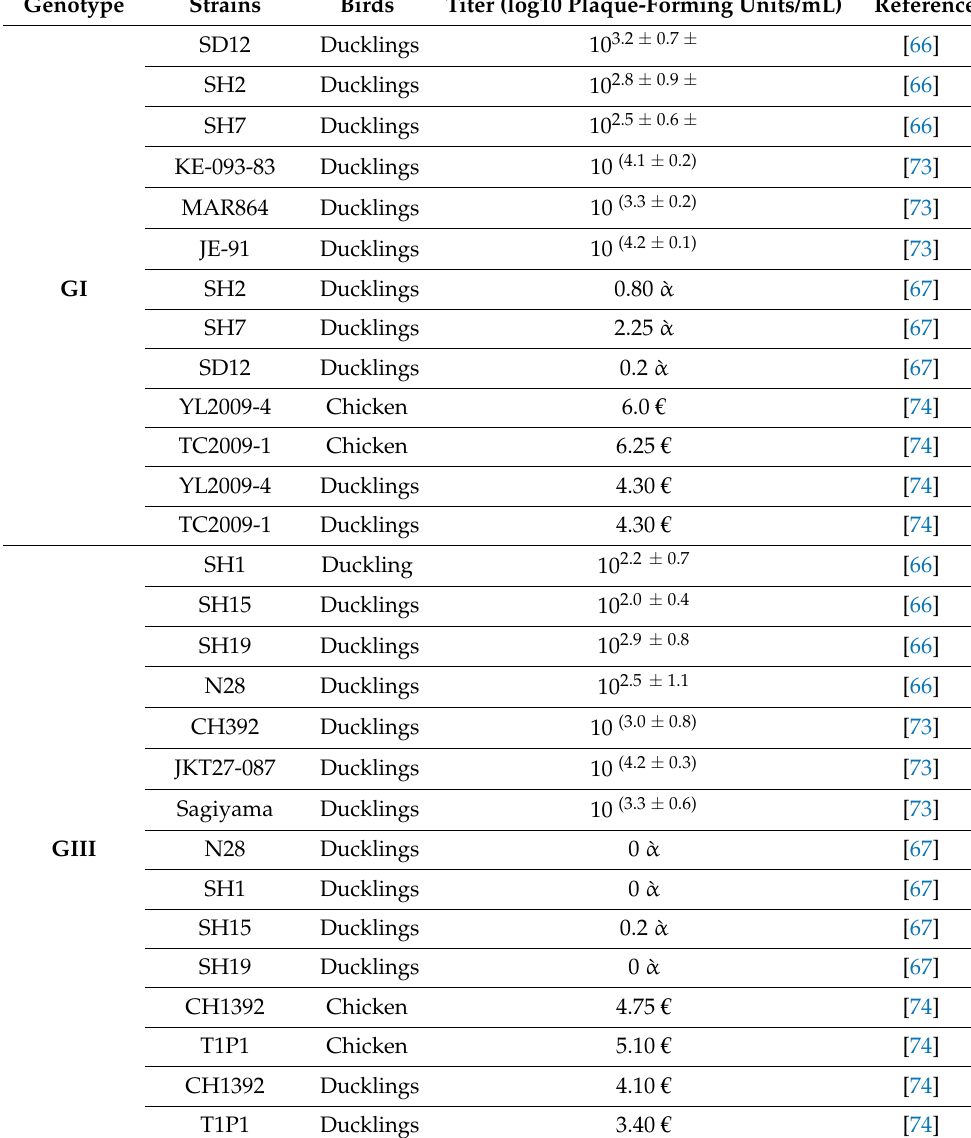
Table 2. Viral titers of birds inoculated with the Japanese encephalitis virus GI and GIII strains.